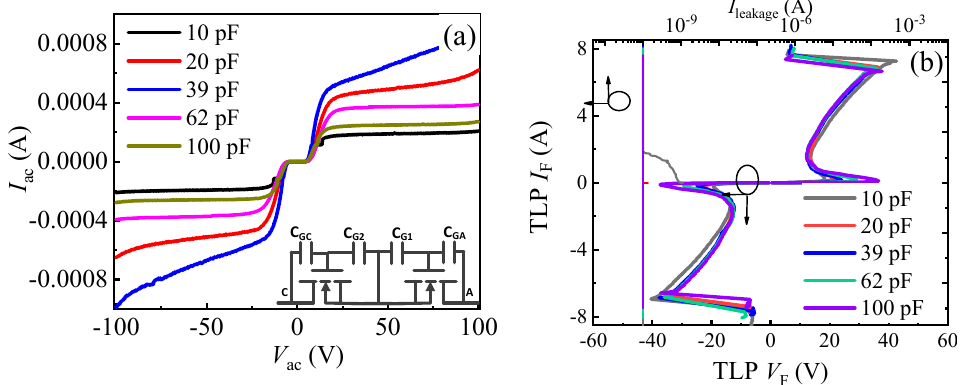
Figure 10. The bidirectional leakage current characteristics ( a ) and TLP I–V characteristics ( b ) of diode 2 with different C G1 ( C G2 ) values. The inset of Figure 10a is the equivalent circuit of diode 2.